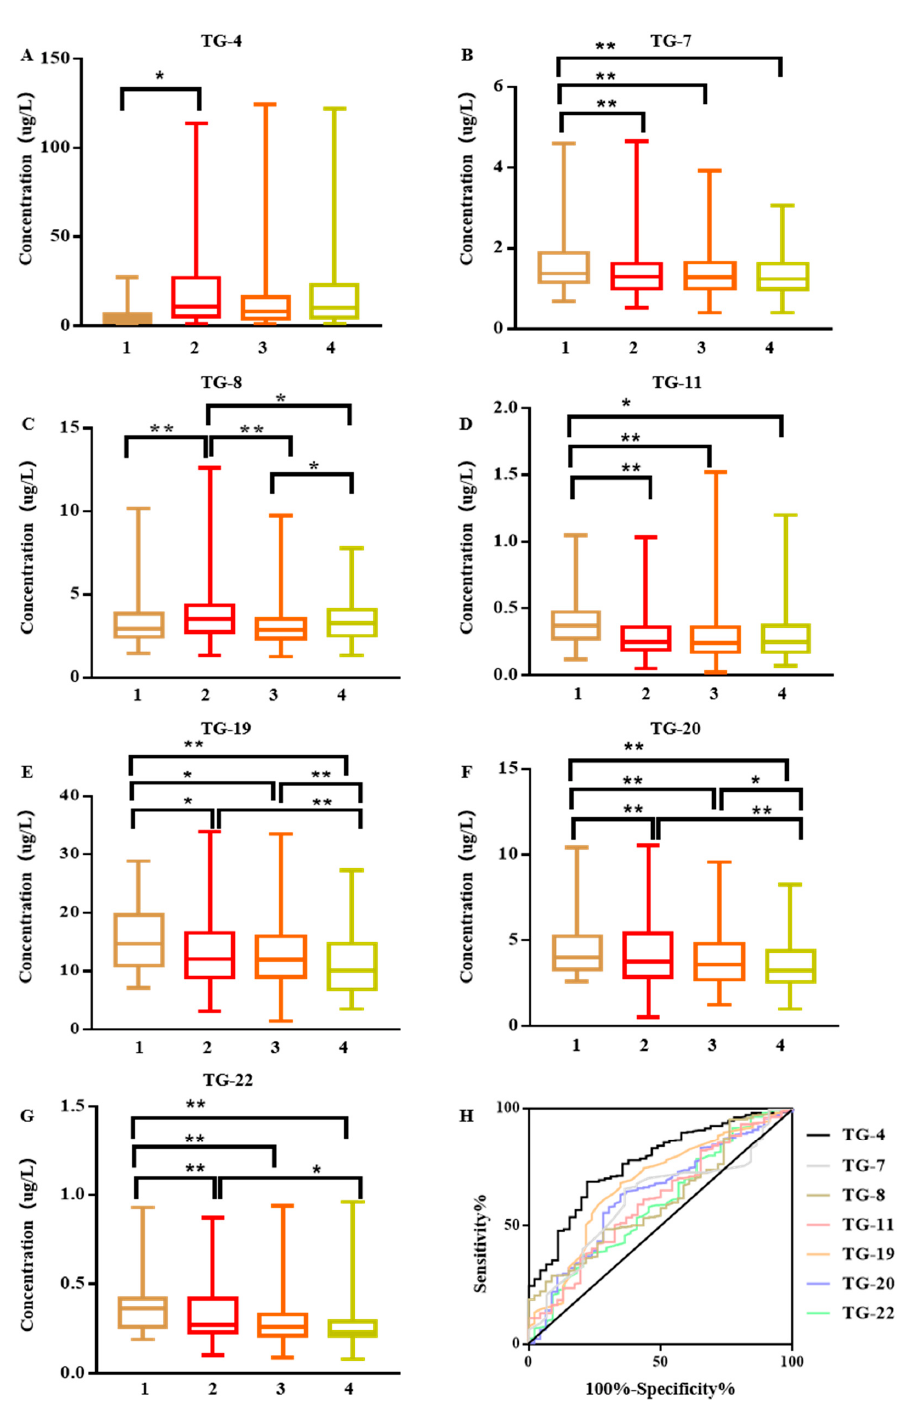
Figure 1. ( A – G ), 1, control; 2, lung cancer before the operation; 3, lung cancer after the operation after three to seven days; 4, lung cancer after the operation after four to six weeks. Box and whisker plots of the measured concentrations of TG-4, TG-7, TG-8, TG-11, TG-19, TG-20, and TG-22 in the exhaled breath 1 h after meals of the study groups, (least significant difference test) LSD-t analysis of variance. * p < 0.05; ** p < 0.01. ( H ), ROC curve analysis was performed on the exhaled air 1 h after the meal in the control group and the lung cancer group before the operation. ROC curves for the TG-4, TG-7, TG-8, TG-11, TG-19, TG-20, and TG-22 breath model in the diagnosis of lung cancer. The area under the curve of TG-4, TG-7, TG-8, TG-11, TG-19, TG-20, and TG-22 were 0.766, 0.611, 0.636, 0.682, 0.604, 0.611, and 0.625,